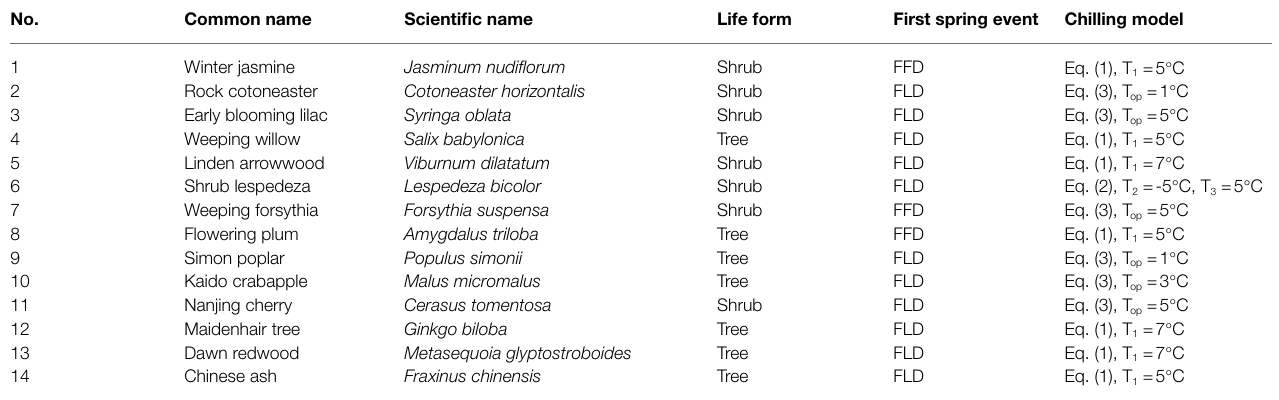
TABLE 1 | Summary of species investigated in this